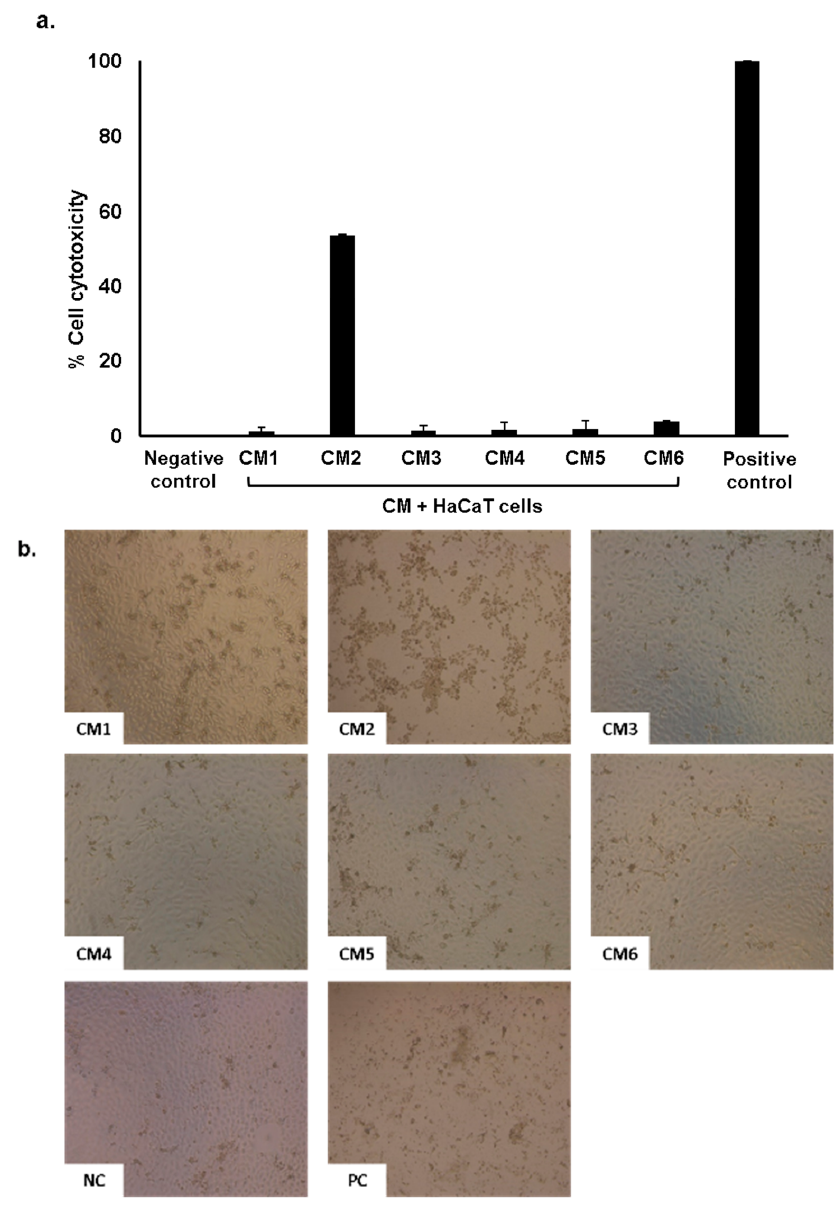
Figure 4. Host cell cytotoxicity assays of conditioned medium against HaCaT cell lines. Briefly, HaCaT cells were grown to (80–90%) confluency and then exposed to 100 µL of CM in a 96 well plate for 24 h at 37°C in the presence of 5% CO 2 and 95% humidity. Next day, Lactate dehydrogenase LDH released was determined as described in material and methods. ( a ) All CM tested were non-toxic, except CM2 that exhibited toxicity against HaCaT cells. ( b ) Representative images of cell monolayer incubated with CM.